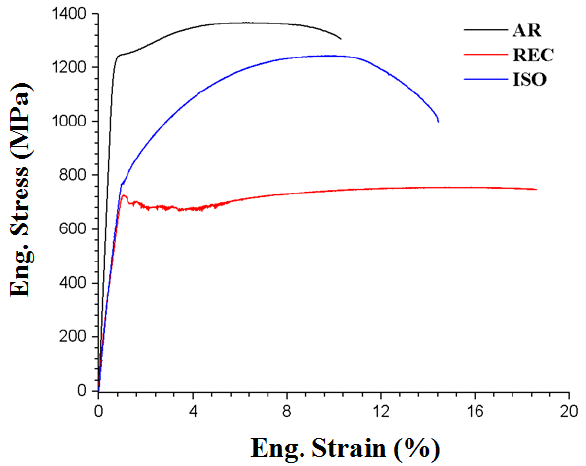
Figure 10. Orientation maps (OIM) of heat-treated samples in the normal direction (ND), third-order kernel average misorientation (KAM) map, and Taylor factor map.